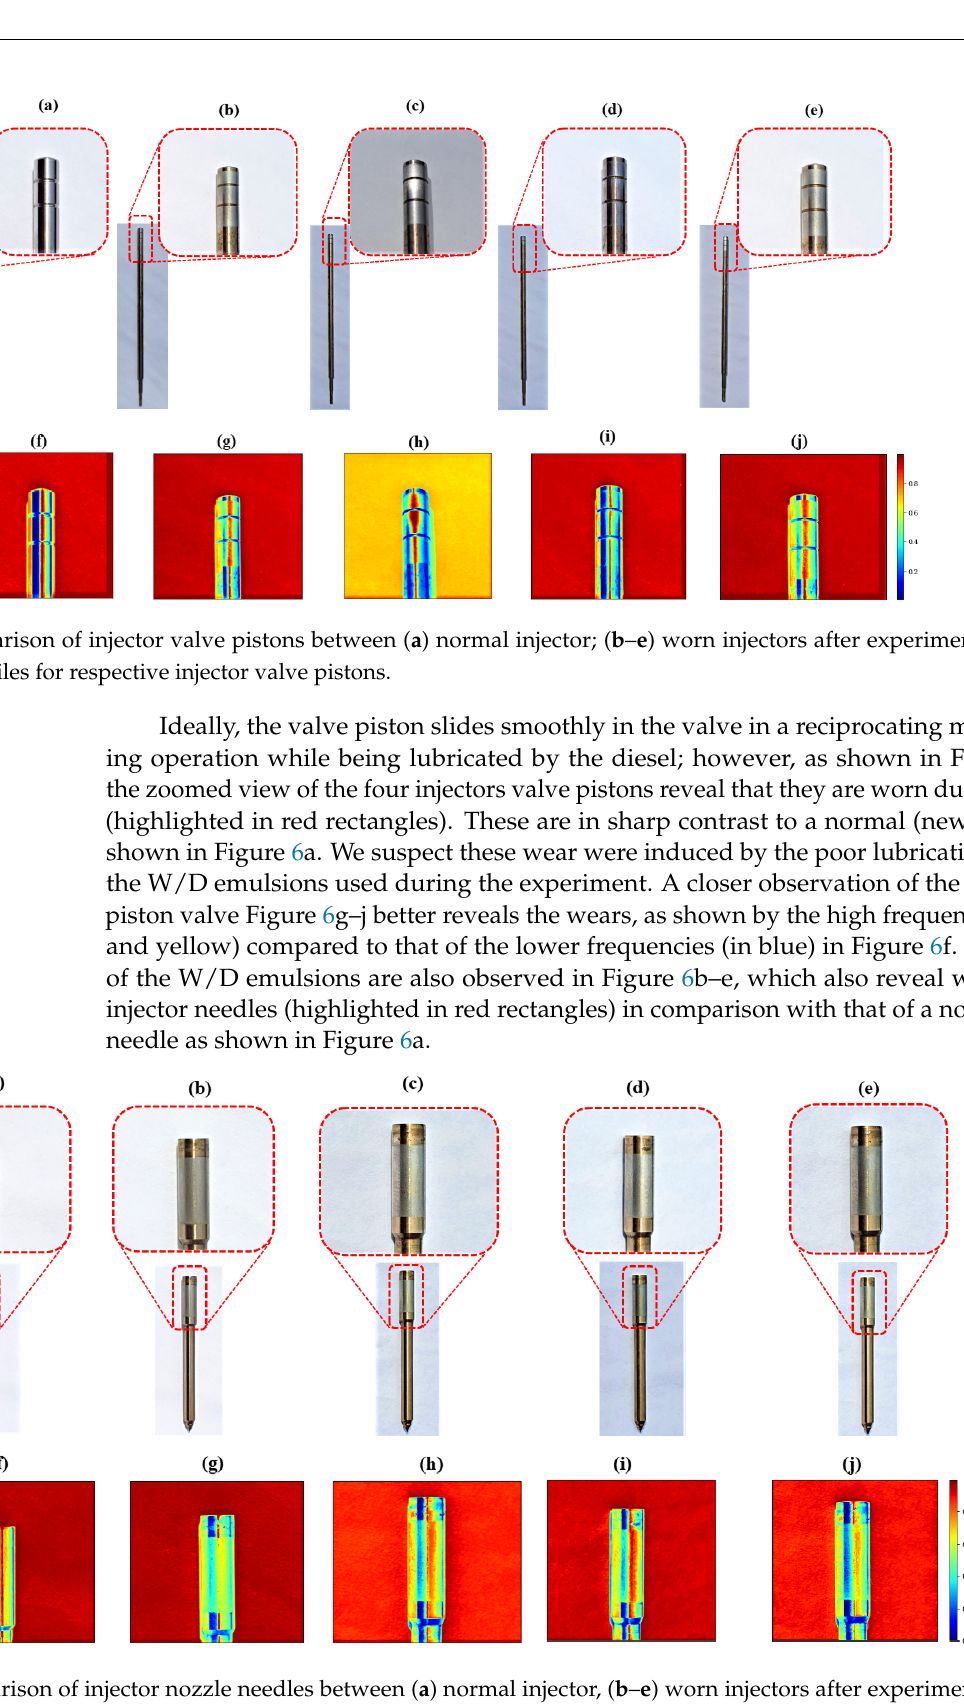
Figure 7. Comparison of injector nozzle needles between ( a ) normal injector, ( b – e ) worn injectors after experiment, and ( f – j ) surface profiles for respective injector valve